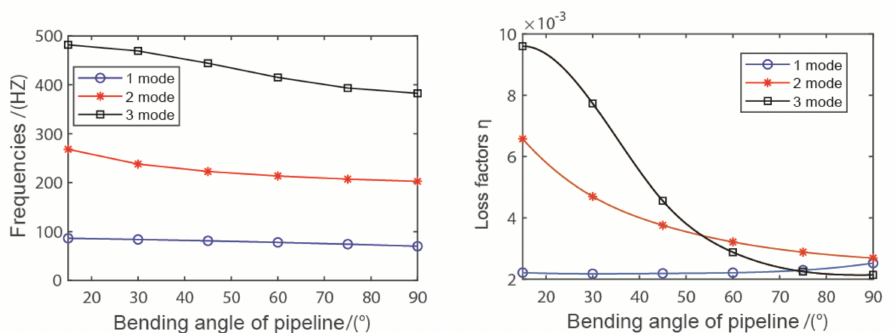
Figure 13. The influence of angle of pipeline.